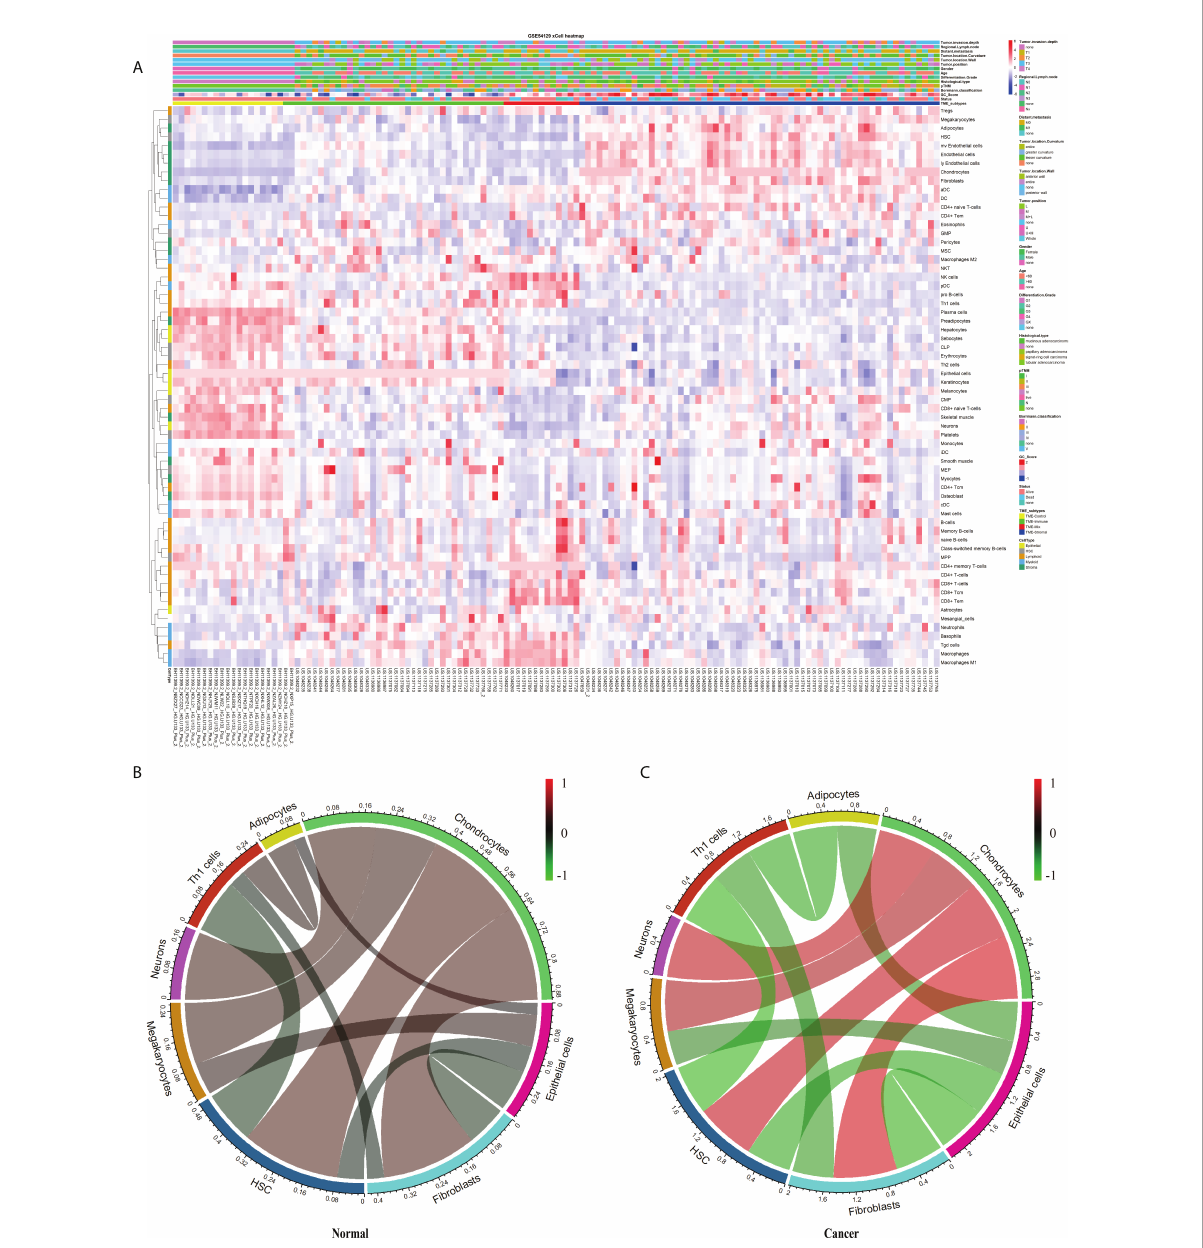
FIGURE 2 The landscape of the TME in GC. (A) Heatmap of 64 TME cells for 111 GC and 21 normal samples. pTNM, Borrmann classi fi cation, Tumor invasion depth, Regional lymph node, Distant metastasis, Tumor location, Tumor position, Gender, Age, Tissue differentiation, Histological type, Status, Cluster, and CellType were shown as patient annotations. (B, C) Correlation of cell proportion among the 12 survival-related cell populations in normal and tumor groups. Red, positive correlation; green, negative correlation; black, no correlation. The width of the connection line was correlated with the absolute value of its corresponding Spearman correlation coef fi cient. Note that the cell bar in panels (B) and (C) has a different